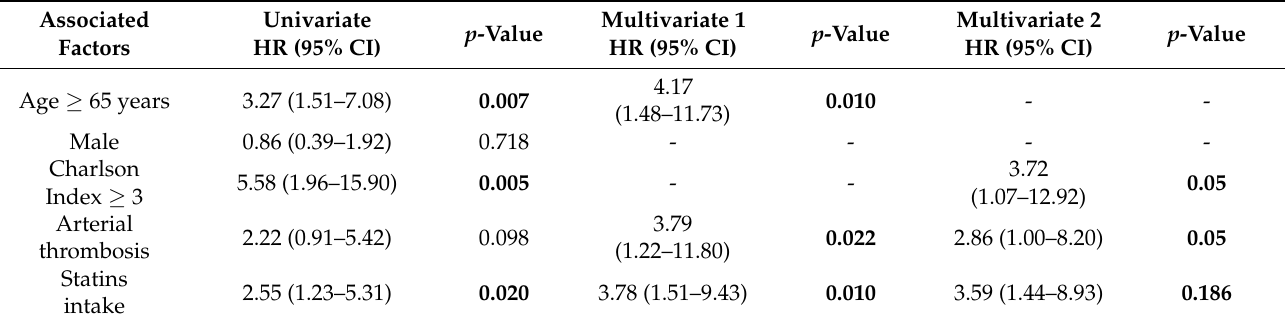
Table 3. Univariate and multivariate Cox regression analysis ( N =